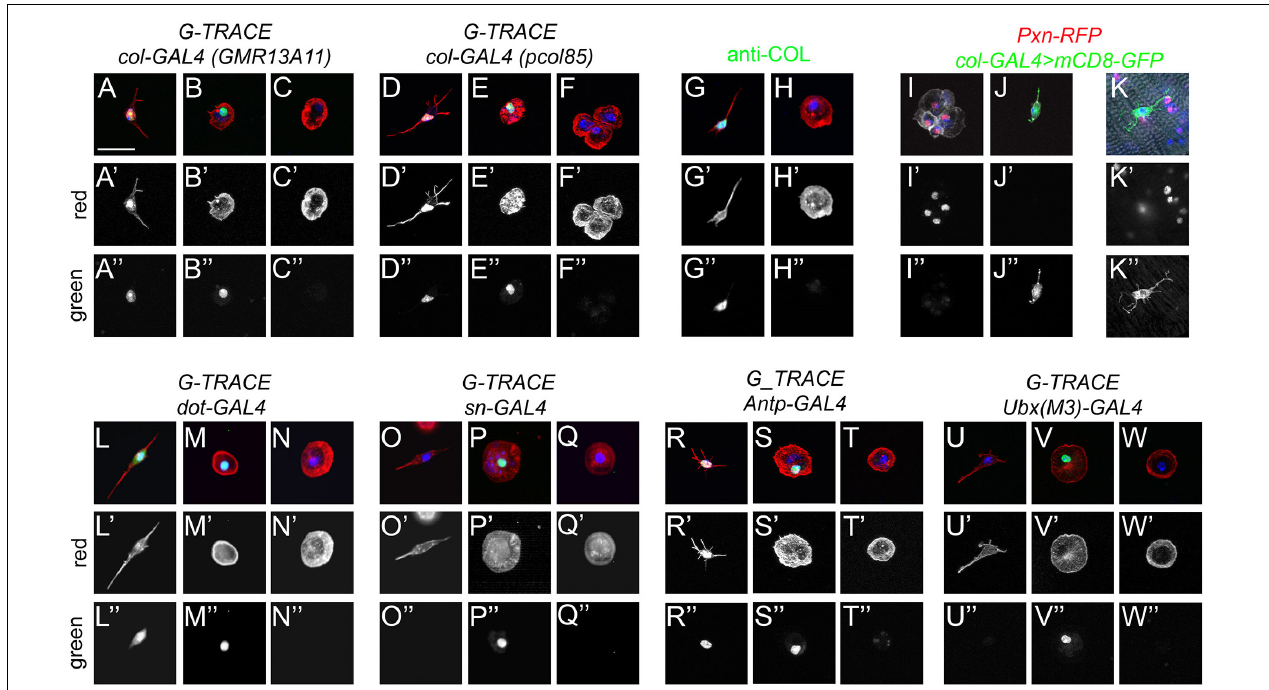
FIGURE 6 | Fusiform cells are derived from the lymph gland posterior signaling center. (A–F,L–W) Cell lineage analyses of adult blood cells origin. Confocal views showing the different types of fusiform (A,D,G,J–L,O,R,U) or round (B,C,E,F,H,I,M,N,P,Q,S,T,V,W) cells recovered in adult flies expressing the G-TRACE reporter transgenes under the control of the indicated drivers. Present and past expression of the drivers are revealed by nuclear RFP (red, A’–F’ and L’–W’ ) and nuclear GFP (green, A”–F” and L”–W” ), respectively. (G–H) Expression of Col (green) in adult blood cells as revealed by immunostaining. (I–K) Confocal views of adult bleeds (I,J) and abdominal hematopoietic hub (K) from Pxn-RedStinger, pcol85-GAL4,UAS-mCD8-GFP flies. (A–W) Scale bar 20 µ m. Cells were counterstained with phalloidin ( A–H,L–W : red; I–K : white) and DAPI (blue).